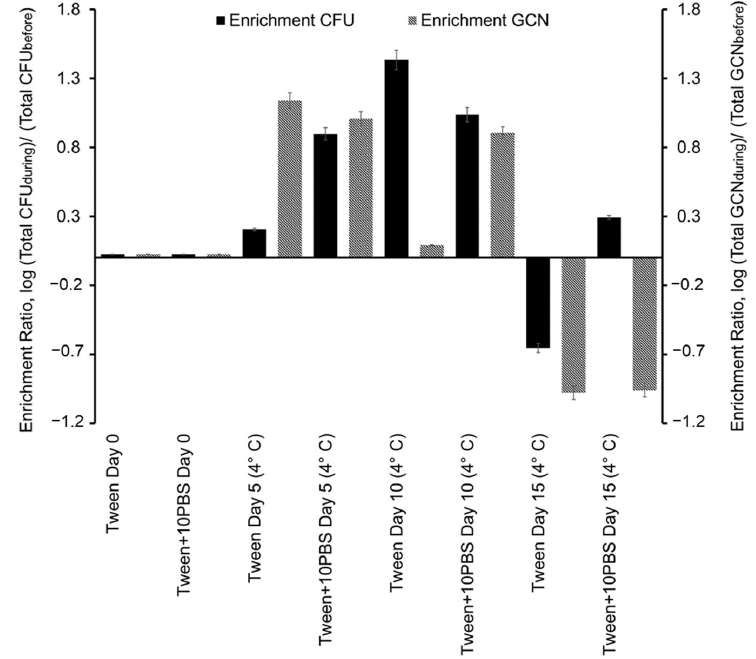
Figure 4. Enrichment ratio of the log of the airborne bacterial concentration based on viable colony forming units (CFUs), left axis, and on bacterial genome copy number (GCN), right axis, for the aerosol samples stored at 4 °C (during) compared to the total amount of CFUs or GCNs nebulized into the chamber (before). The baseline of 0 is in reference to the ratio of Day 0 to itself (Day 0).